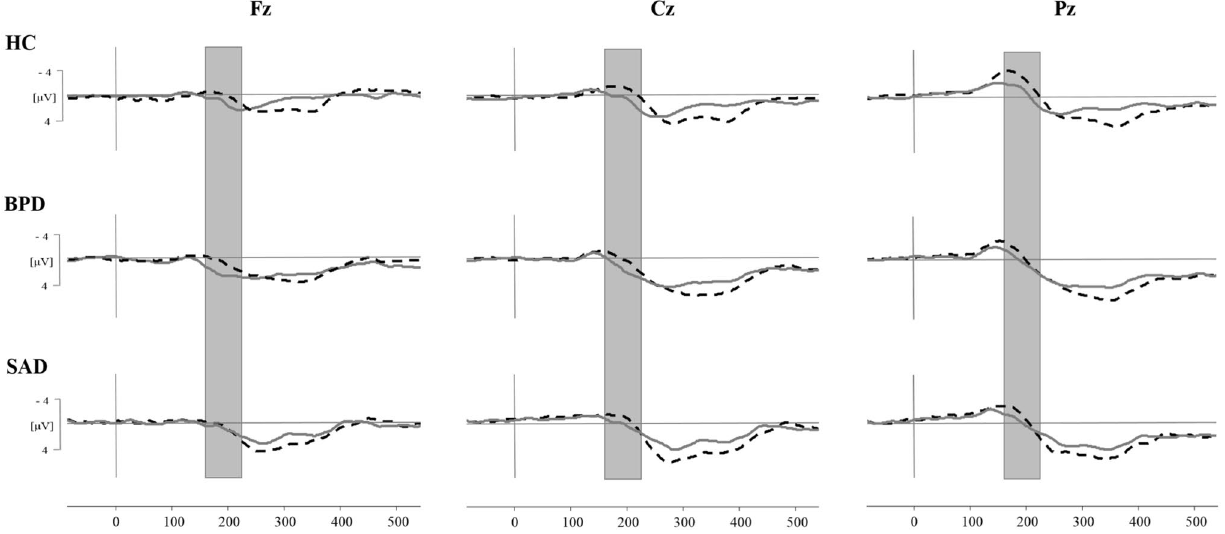
Figure 1. Grand averages of event-related potentials of each group at the frontal (Fz), central (Cz) and parietal (Pz) position. Dashed black line inclusion condition, solid grey line overinclusion condition, HC healthy controls, BPD borderline personality disorder, SAD social anxiety disorder. Amplitude differences between the conditions and groups were examined for the P2 time window at 160–225 ms (grey square).